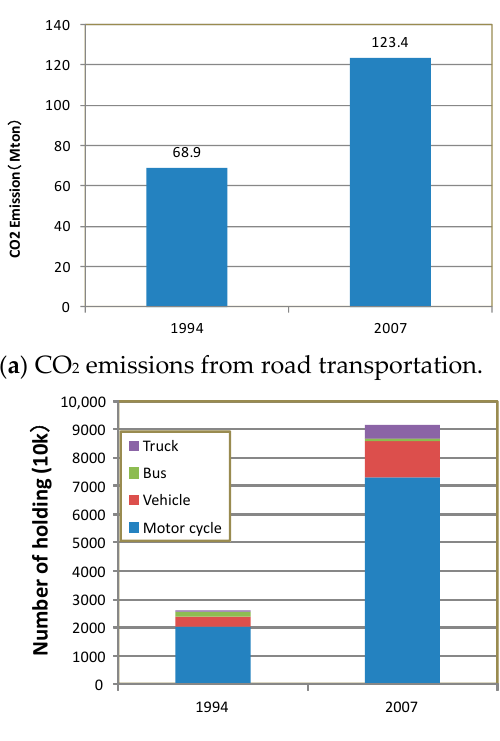
Figure 2. Indian road transportation.